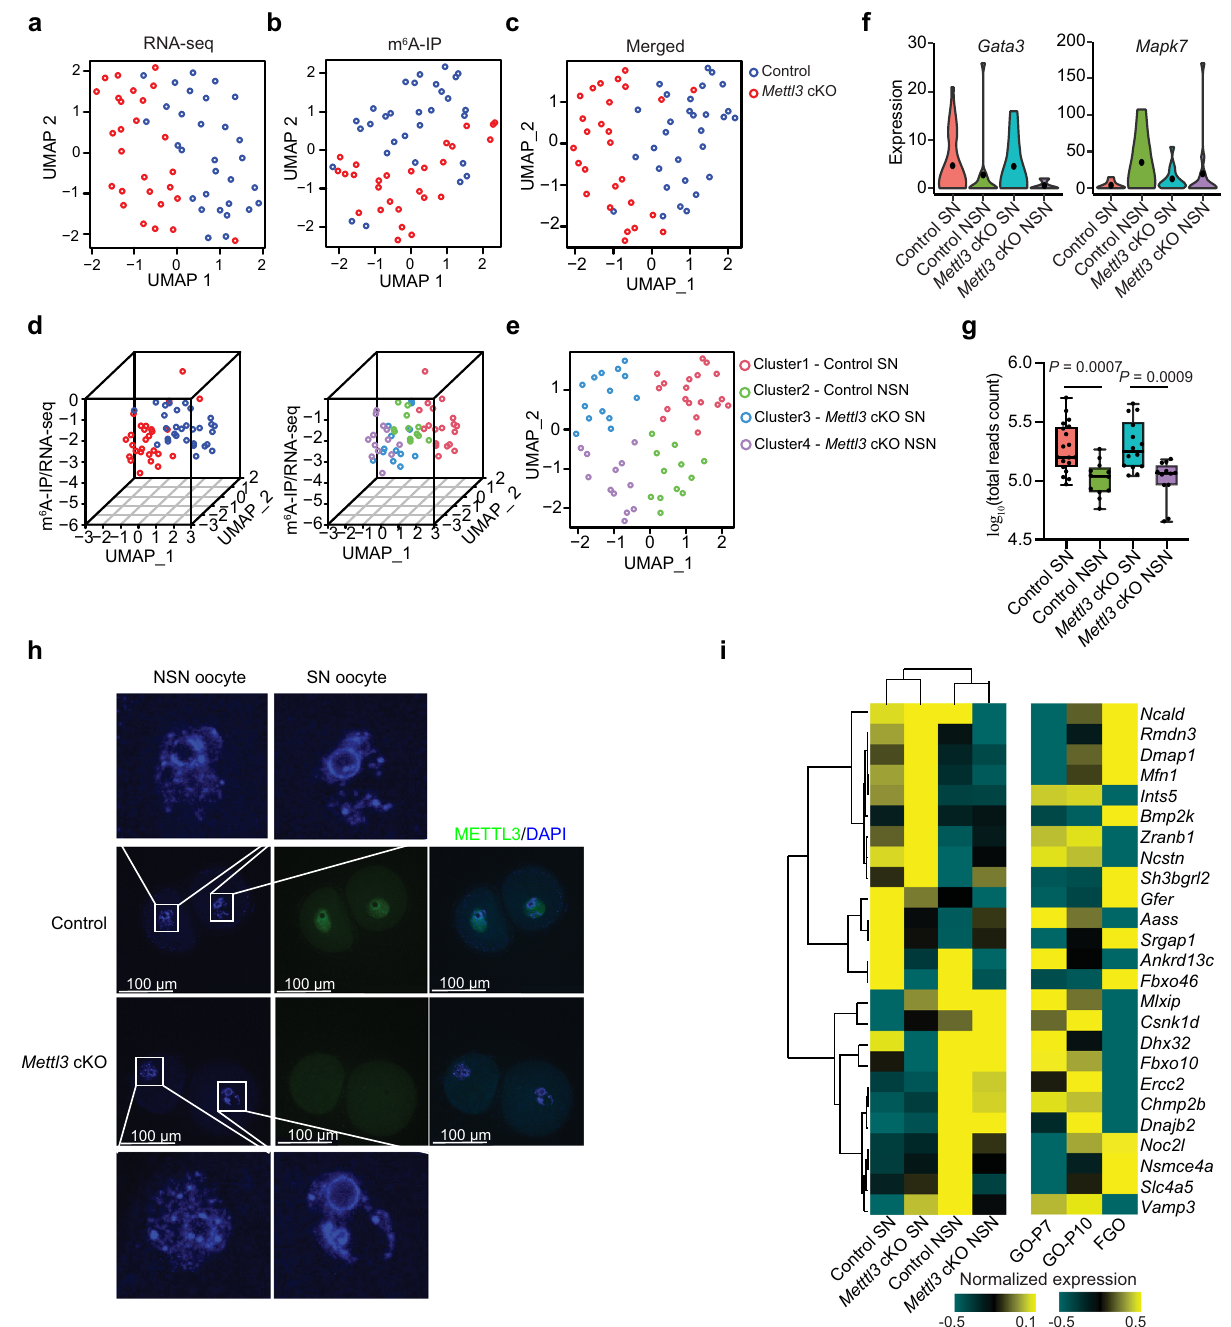
Fig. 3 | scm 6 A-seq distinguishes surrounded nucleolus (SN) and non- surrounded nucleolus (NSN) oocytes. a – c Uniform manifold approximation andprojection(UMAP)plotbasedonthereadscountmatrixofRNA-seq( a )and m 6 A-IP ( b ), and merged total reads count of single GV oocytes ( c ). The UMAP plot is colored on the basis of the cells type. Source data are provided as a Source data fi le. d The 3D plot showing the relative m 6 A level of each GV oocyte based on the UMAP results, colored by cells type (left) and cells reclassi fi ed by the comprehensive analysis of the gene expression matrix reduced dimensions by UMAP and m 6 A level (right). Source data are provided as a Source data fi le. e The two-dimensional UMAP diagram showing the cell populations on the basis of the classi fi cation results in ( d ). The Clusters 1 – 4 of cells were rede fi ned as Control SN, Control NSN, Mettl3 cKO SN, and Mettl3 cKO NSN clusters according to the expression of marker RNAs and genome type of oocytes. Source data are provided as a Source data fi le. f Violin plot showing the quality of markers Gata3 and Mpak7 expression in oocytes in different clustering populations. g Combined box and scatter plot showing the difference in RNA